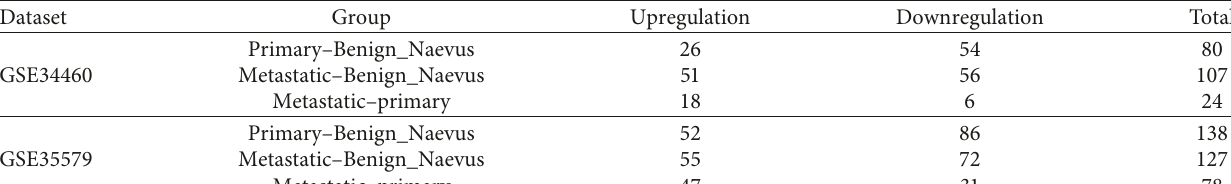
Table 1: Identification of differentially expressed miRNAs (DEmiRNAs) in GSE34460 and GSE35579 datasets. Dataset Group